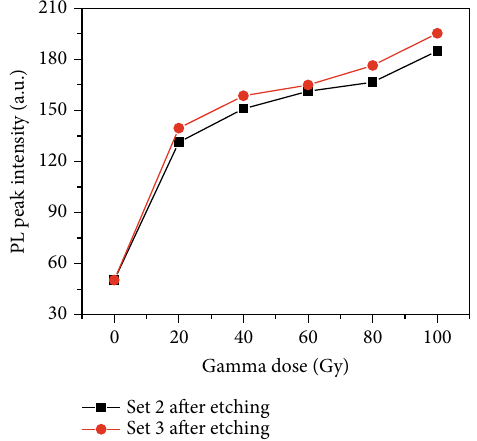
Figure 8: Variation of PL intensity with respect to di ff erent gamma doses for PM-533 SSNTDs after